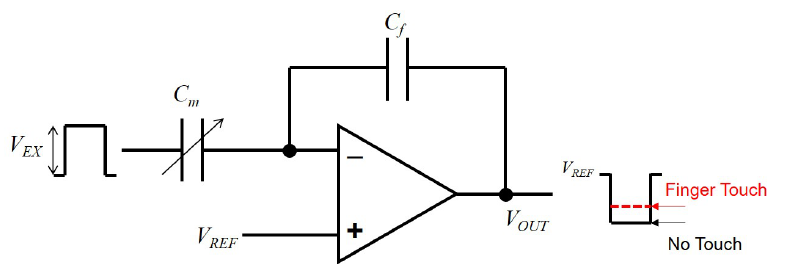
Figure 8. Charge amplifier circuit. The change of C m causes different output voltage levels ( V OUT